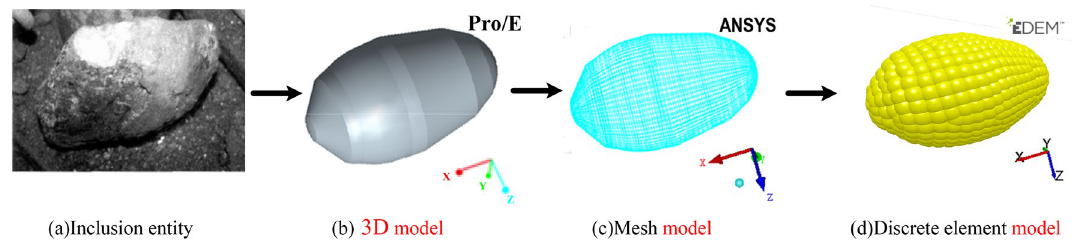
Figure 1. Evolution process of inclusion discrete element